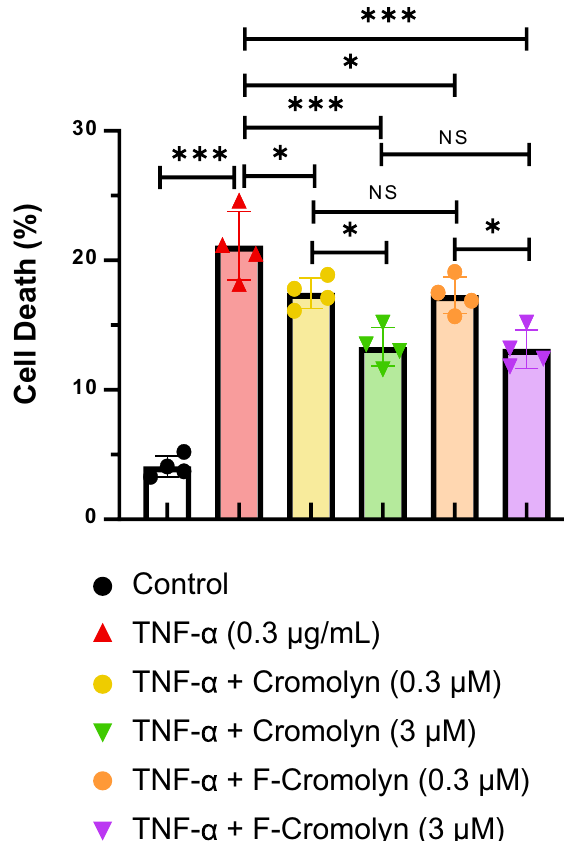
Figure 5. Cromolyn and F-Cromolyn reduced TNF-α induced cell death in the HMC3 microglia cell line. The comparisons of multiple groups were carried out by one-way ANOVA, followed by Bonferroni’s post-test. * p < 0.05, ** p < 0.01, *** p < 0.001, and NS (no significant